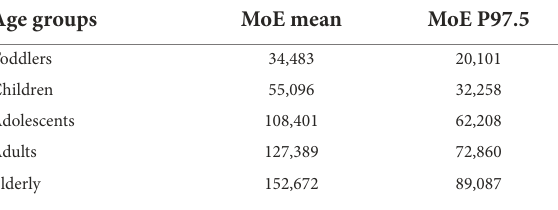
TABLE 3 Mean and 97.5th percentile MoE values of the different age groups for 2019–2022, calculated with a probabilistic